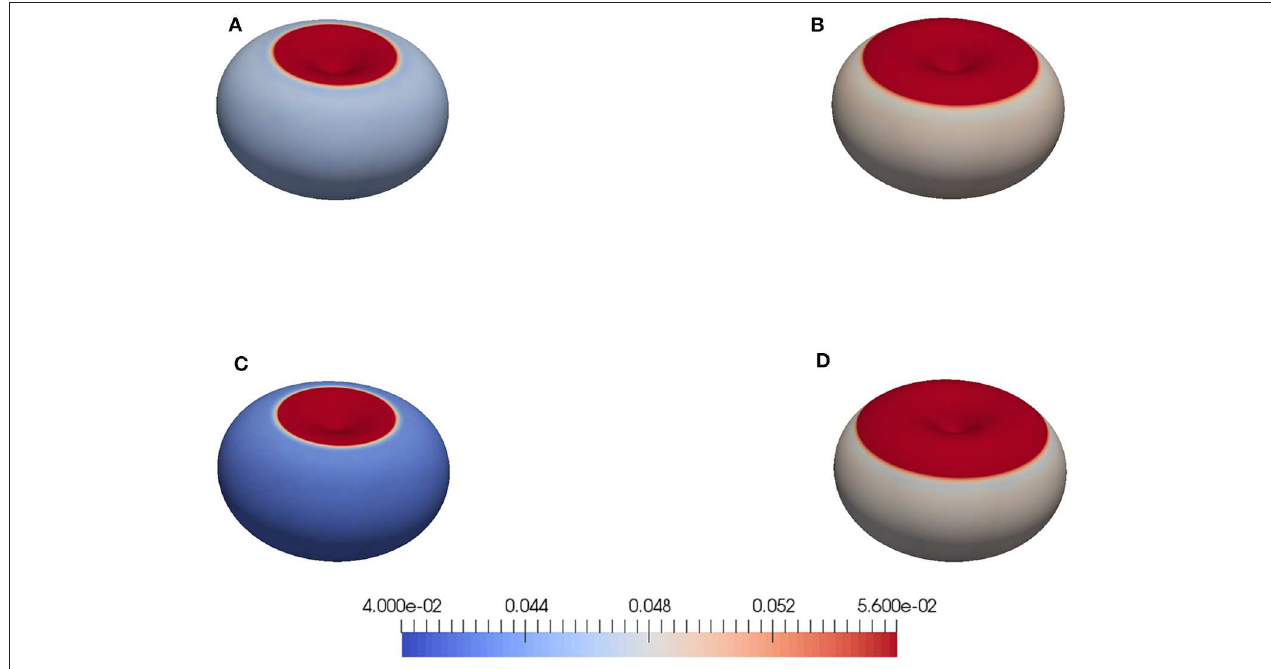
. U h u h , c | − | 0.056 in red, whilst values in between are = 12. For (C) , the = 30. =